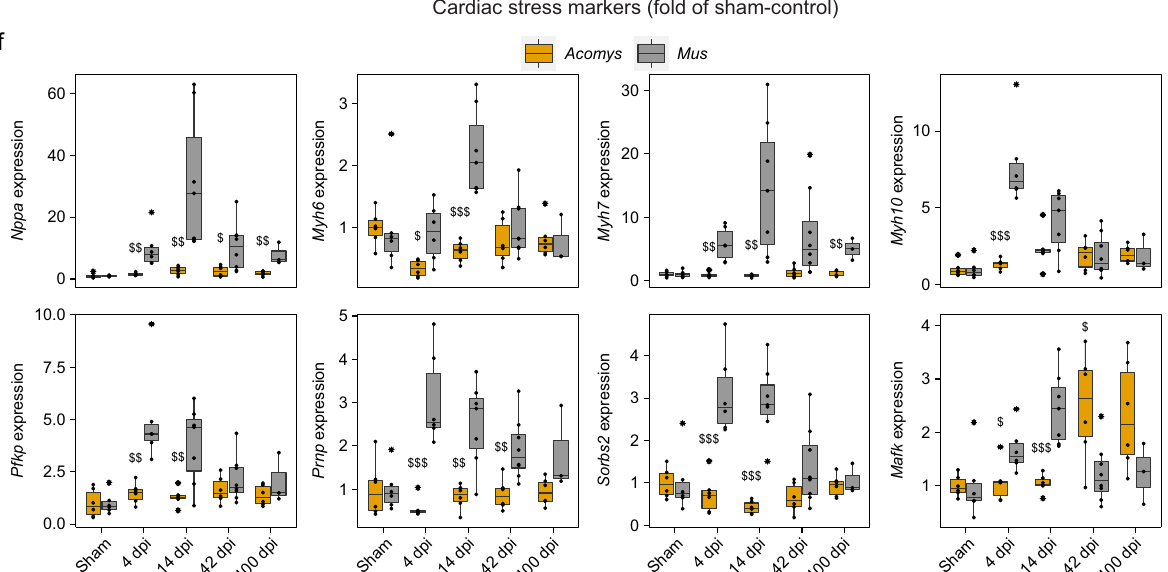
Fig. 2 Near-absence of infarction-induced remodeling in Acomys . a Infarct size of mice injected with Evans blue 24 h after surgery. Unpaired t test. b TUNEL-reactive dying cells (yellow arrows) in the scar area of infarcted hearts. Scale bar = 50 µm. c Heart to body weight ratio progression over time. d Heart size progression, based on transversal stacks stained with Masson ’ s Trichrome (see ‘ Methods ’ ). e Heart wall thickness derived from fi ve points-of-measurements along the scar wall. f Relative gene expression from whole heart ventricle homogenates subjected to RT-qPCR. Samples have been normalized to the sham-control ( Acomys or Mus ). b − f Two-way mixed ANOVA followed by Bonferroni post hoc test. For all comparisons: * is signi fi cant compared to Acomys -sham, # compared to Mus -sham, $ is signi fi cant in an inter- species comparison of the same time point (e.g. 100 days to 100 days). * is p < 0.05, ** is p < 0.01, and *** is p < 0.001. Box plots represent the median, interquartile range (IQR), minimum (25th percentile – 1.5 × IQR), and maximum (75th percentile – 1.5 × IQR). All bar graphs represent the mean ± standard error of the mean (Fig. 4l). In line with their immature phenotype, the number of (Fig. 4l and Supplementary Fig. 5d). Overall, our data suggest a Ac CMs positive for EdU was higher compared to B6 at 14 days modestly increased proliferative potential of the ventricular after MI (3.6 ± 0.5% vs 1.2 ± 0.07%) and borderline signi fi cant myocardium to respond to ischemia in Ac, possibly due to the for phosphorylated Histone H3 (0.12 ± 0.03% vs 0.05 ± 0.007%) presence of less differentiated cardiomyocytes.